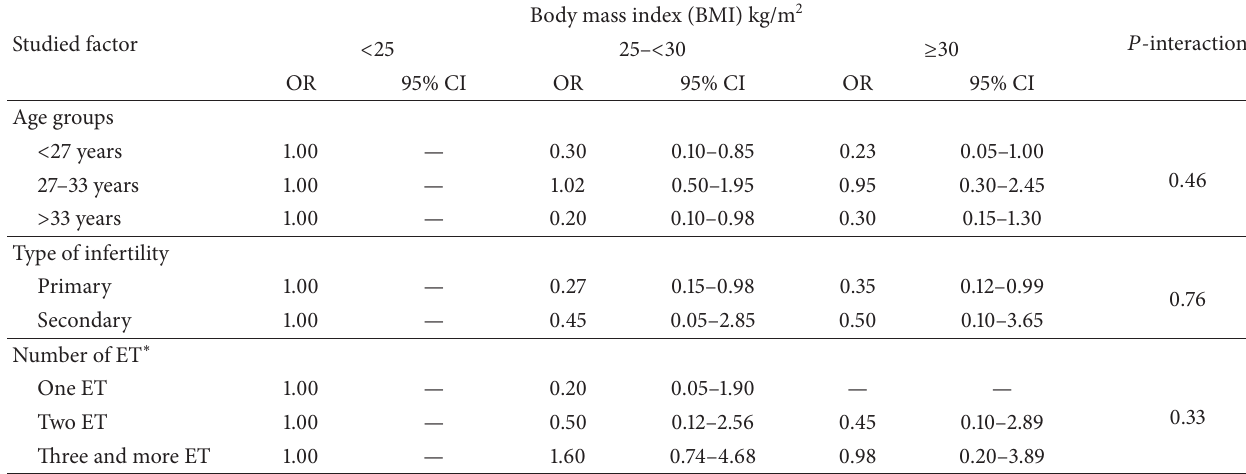
Table 3: Positive pregnancy outcome associated with body mass index (kg/m 2 ) by age groups, infertility type, and number of embryo transfer